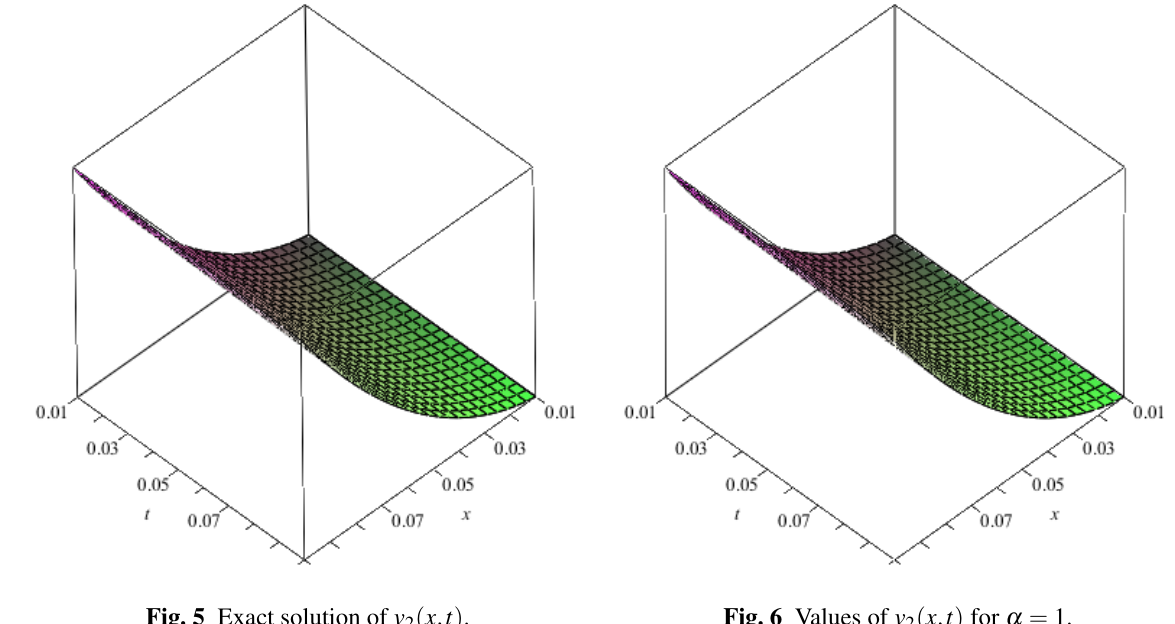
Fig. 5 Exact solution of v 2 ( x , t ) . Fig. 6 Values of v 2 ( x , t ) for α = 1.